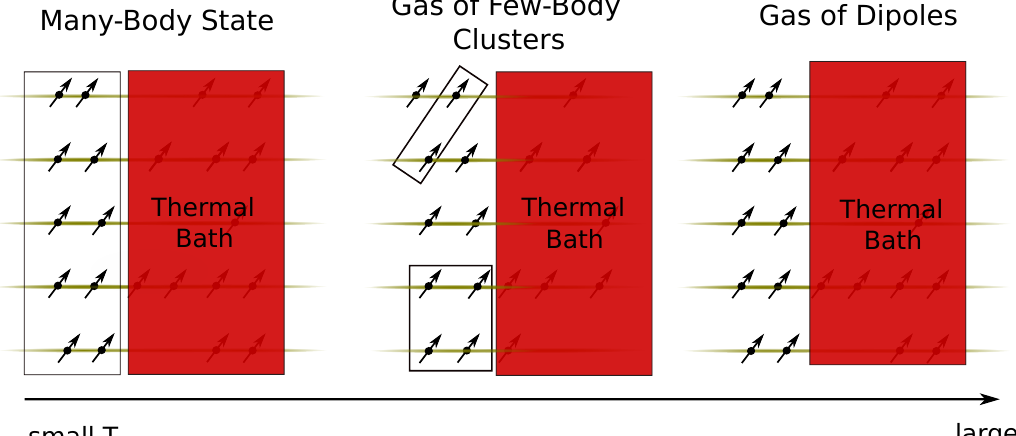
Figure 1. The system of interest is five one-dimensional tubes filled with two dipolar particles with dipole moments aligned at the so-called “magic angle”. The system is in a thermal equilibrium with a bath at temperature T . At high temperatures, the system will consist of a gas of independent particles, and at zero temperature the attraction between the layers will lead to a certain bound structure. At intermediate temperatures, various few-body clusters will